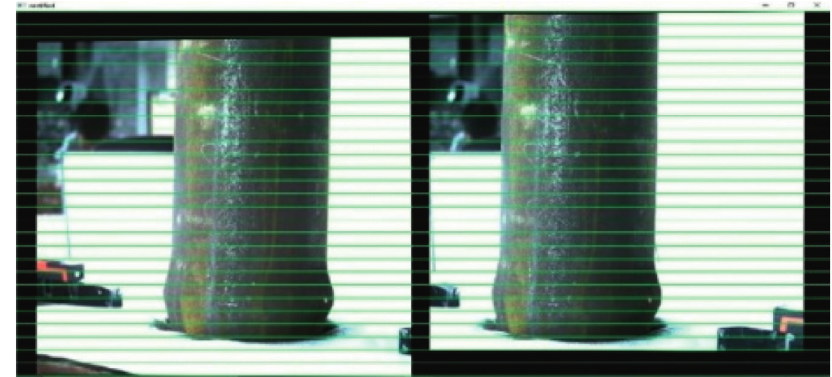
Figure 3: Stereo rectification.